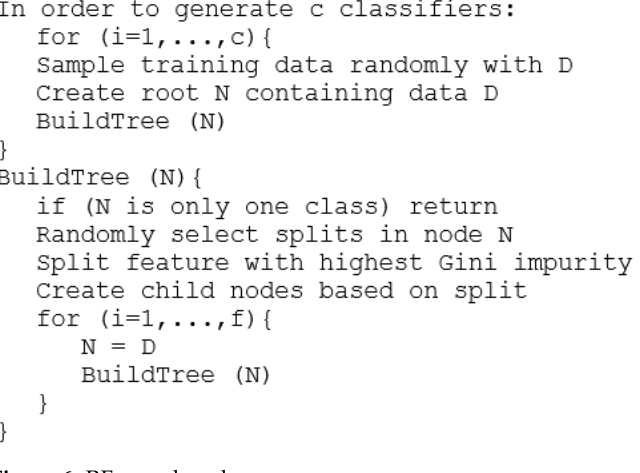
Figure 6. RF pseudocode.